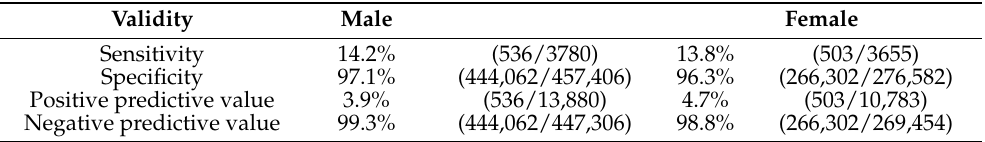
Table 8. Validity analysis of the PHQ-9 for predicting hospitalizations for depression, self-harm, or